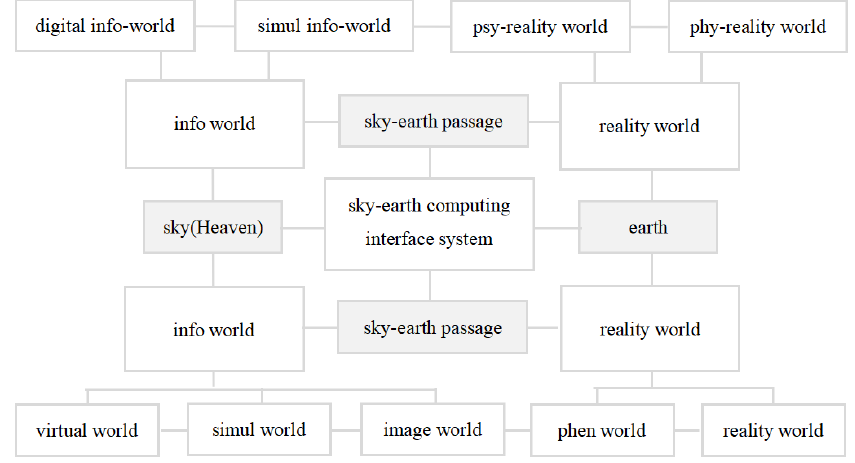
Fig. 2. Conception of an interface system of sky-earth computing between info. world and realistic